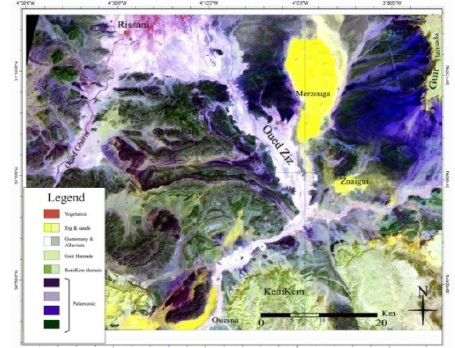
Figure 8: (a) False colour combination with highest OIF (R=b8, G=b11,